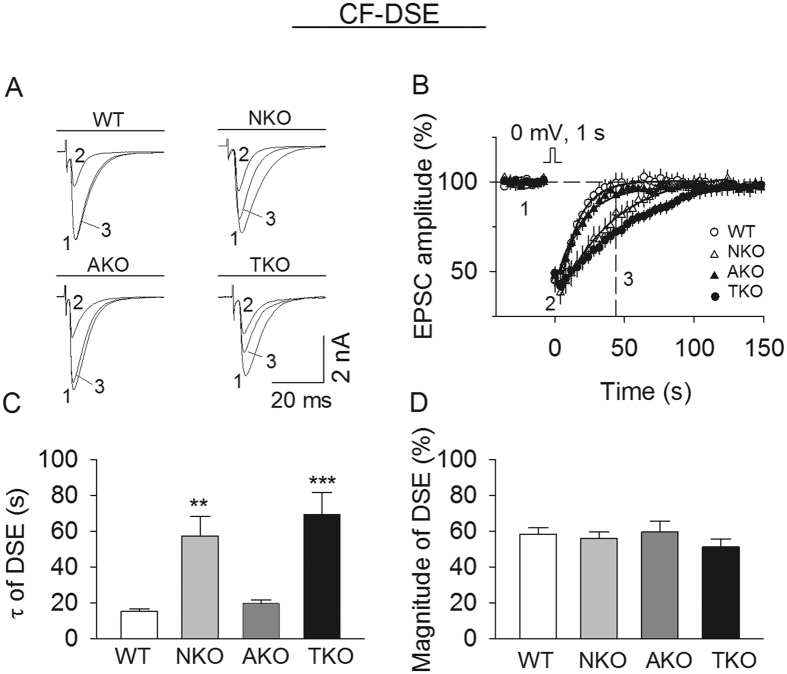
Effects of global and cell type-specific knockout of MAGL on CF-DSE in PCs.(A,B) Sample traces (A) and average time courses of CF-EPSCs (B) in response to a brief depolarization in cerebellar slices prepared from MAGL-TKO, -NKO, and -AKO mice and their wild-type (WT) littermates (n = 7–11 cells from N = 3–5 mice per genotype). The solid lines are single exponential fitting curves of the decay of CF-DSE, which yield the decay time constant (τ) of DSE shown in (C). (C) Compared with that of WT control, τ of CF-DSE was significantly increased in MAGL-TKO and -NKO mice but was not changed in MAGL-AKO mice (**p < 0.01, ***p < 0.001). (D) MAGL-TKO, -NKO and -AKO did not significantly alter the magnitude of CF-DSE (p > 0.05).